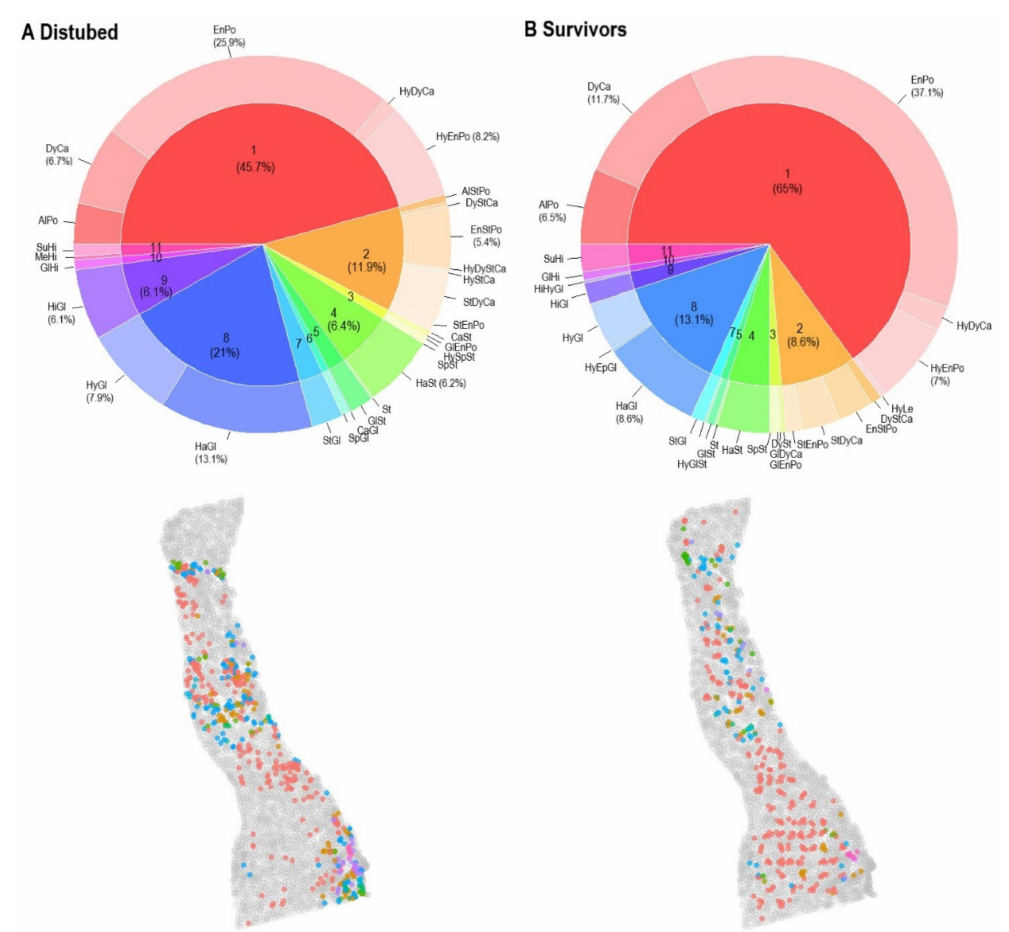
Figure 3. Pie and donut charts of the proportions of soil hydromorphism classes (inner pie) and soil units (outer donut) with maps of their distribution in the Boubin old-growth forest, classified by: ( A ) disturbed and ( B ) sur- vivor trees. Proportions are depicted only if the percentage ≥ 5%. AlPo = Albic Podzols, DyCa = Dystric Cambisols, EnPo = Entic Podzols, HyDyCa = Hyperskeletic Dystric Cambisols, HyEnPo = Hyperskeletic Entic Podzols, HyLe = Hy- perskeletic Leptosols, AlStPo = Albic Stagnic Podzols, DyStCa = Dystric Stagnic Cambisols, EnStPo = Entic Stagnic Podzols, HyDyStCa = Hyperskeletic Dystric Stagnic Cambisols, HyStCa = Hyperskeletic Stagnic Cambisols, StDyCa = Stagnic Dys- tric Cambisols, StEnPo = Stagnic Entic Podzols, CaSt = Cambic Stagnosols, DySt = Dystric Stagnosols, GlDyCa = Gleyic Dystric Cambisols, GlEnPo = Gleyic Entic Podzols, HySpSt = Hyperkeletic Spodic Stagnosols, SpSt = Spodic Stag- nosols, HaSt = Haplic Stagnosols, St = Stagnosols, GlSt = Gleyic Stagnosols, HyGlSt = Hyperskeletic Gleyic Stagnosols, CaGl = Cambic Gleysols, SpGl = Spodic Gleysols, StGl = Stagnic Gleysols, HaGl = Haplic Gleysols, HyEpGl = Hyper- skeletic Epileptic Gleysols, HyGl = Hyperskeletic Gleysols, HiGl = Histic Gleysols, HiHyGl = Histic Hyperskeletic Gleysols, GlHi = Gleyic Histosols, MeHI = Mezic Histosols, SuHI = Supric